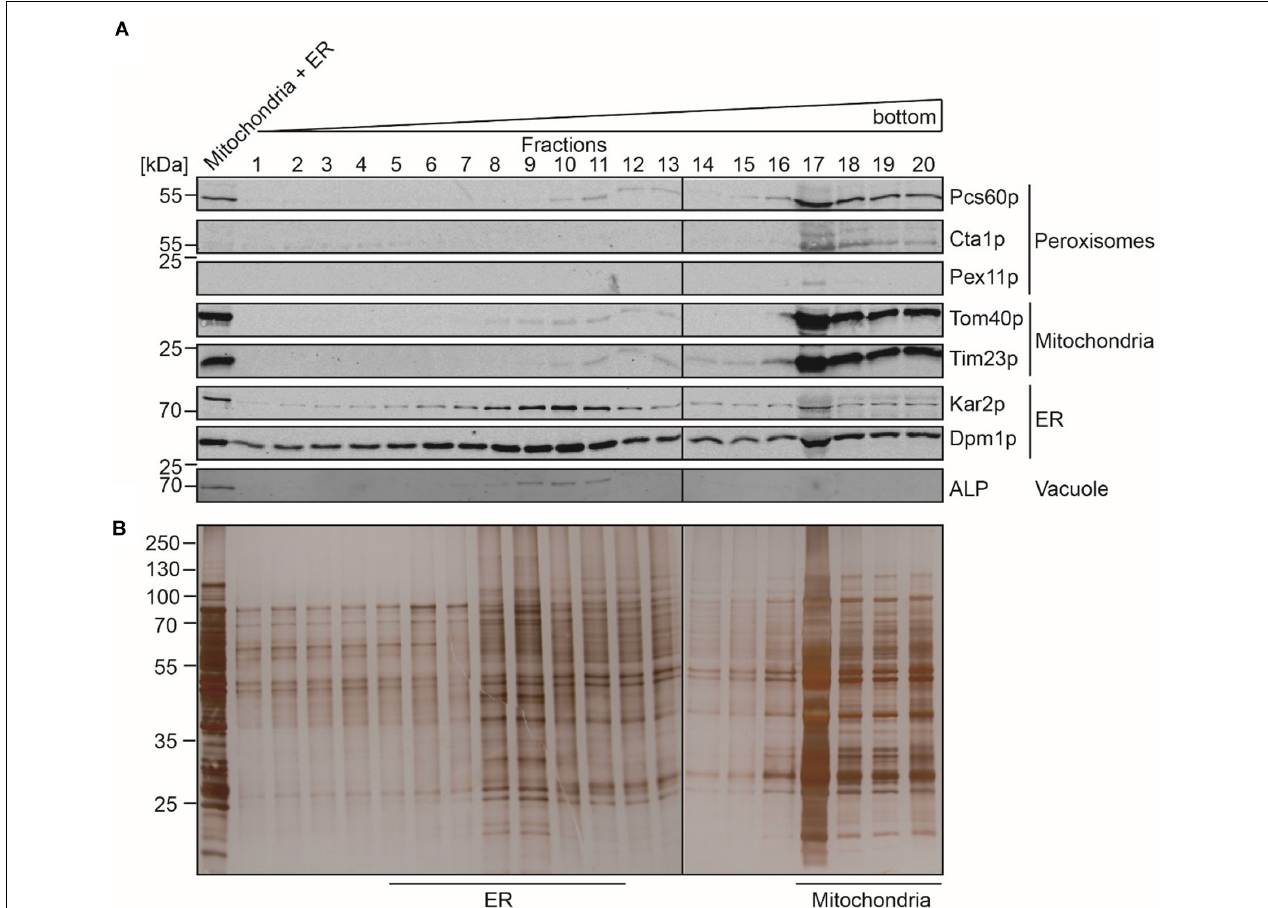
FIGURE 2 | Separation of mitochondria and ER by sucrose density gradient centrifugation. Enriched fractions 13–19 (mitochondria + ER) gained after the first isopycnic density gradient centrifugation were loaded onto a dicontinuous sucrose gradient. Fractions were collected from the top of the gradient. Equal volumes of the indicated gradient fractions (fraction 17 diluted 1:1) were separated by SDS-PAGE and analyzed by (A) immunoblotting using antibodies against Pcs60p (peroxisomal matrix protein), Cta1p (catalase; peroxisomal matrix protein), Pex11p (peroxisomal membrane protein), Tom40p and Por1p (mitochondrial outer membrane protein), Tim23p (mitochondrial inner membrane protein), Kar2p (ER luminal protein), Dpm1p (ER membrane protein), and ALP (vacuole), or by (B) silver staining. ER-peak fractions (5–11) and peak fractions of mitochondria (17–20) were used for lipidomic and fluidity measurements.